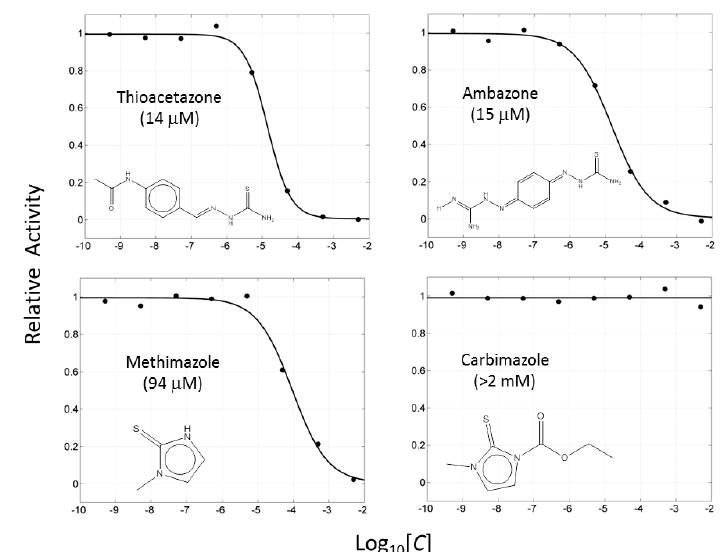
Figure 2. Concentration-dependent inhibitory activities of the representative compounds. Activity is normalized to come under the values in the range of 0 to 1. IC 50 values are written in parentheses.